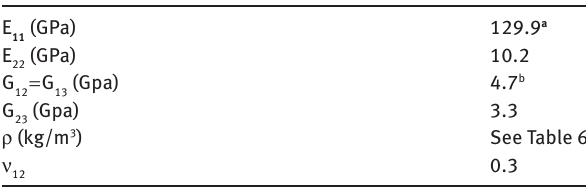
Table 4: Material properties for AS4/PEEK used in finite element analysis [10].